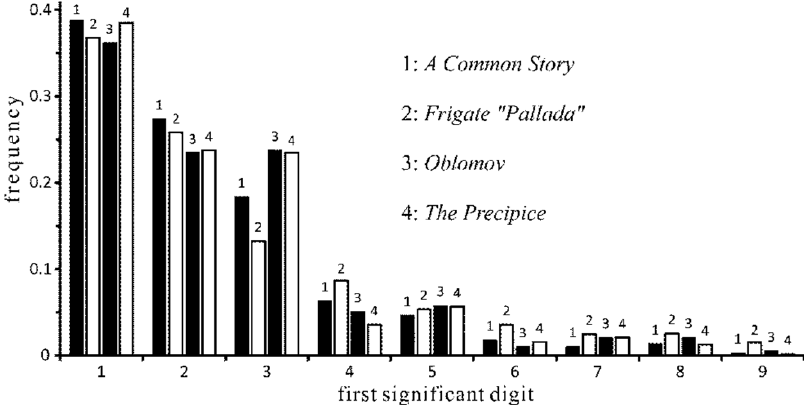
Figure 5. The distribution of the first significant digits of numerals in Goncharov’s texts.